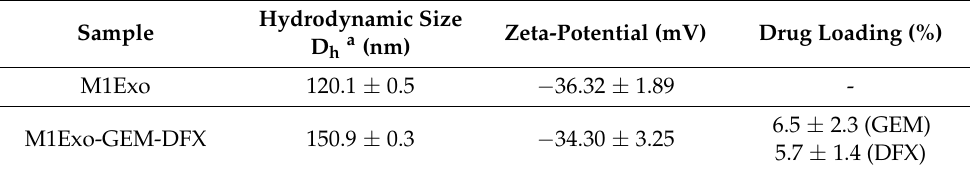
Table 1. Physical properties and drug loading efficiency of M1Exo formulations. a Determined by